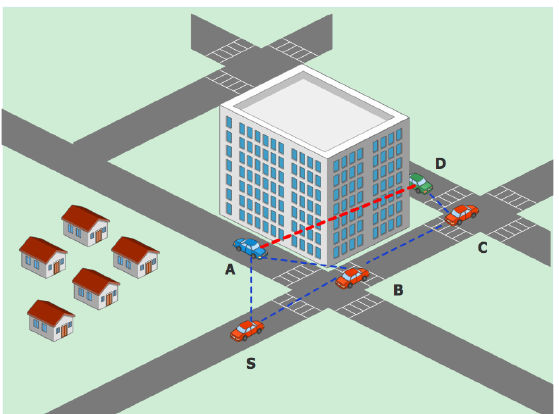
Figure 9. Hop-count-based metric without line of sight (LOS)